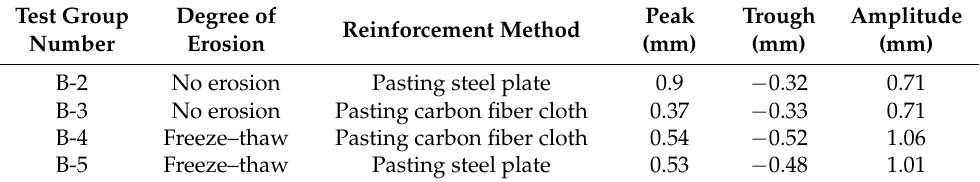
Figure 14. Dynamic displacement diagram of fatigue test process of steel plate strengthened component. Table 10. Table of dynamic displacement change of test plate under 2 million fatigue loads.